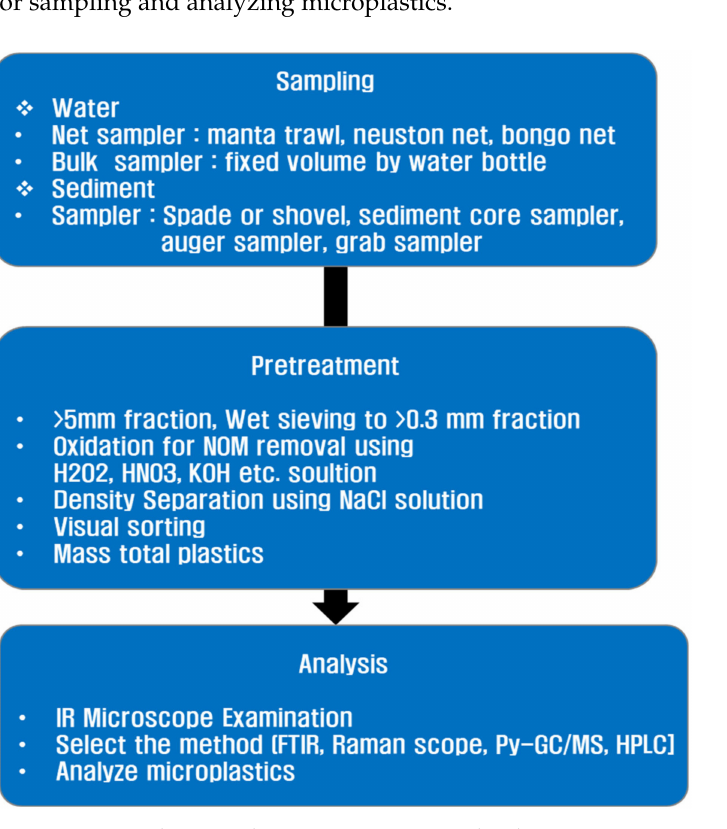
Figure 4. Microplastic analysis steps in water and